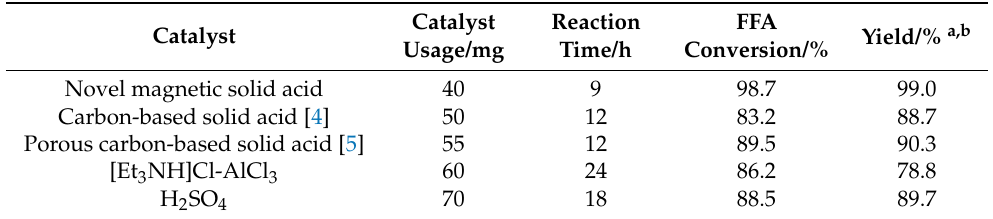
Table 4. The comparative study on other acid